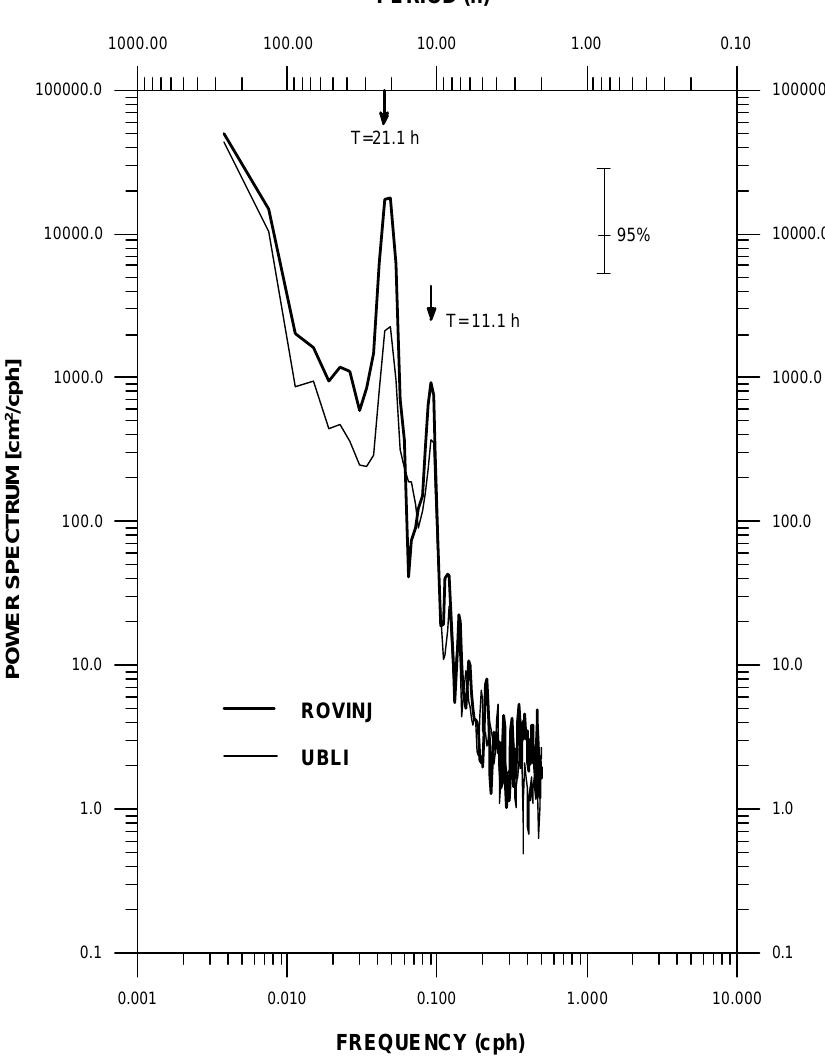
Fig. 5. Power spectra of residual sea levels at Rovinj and